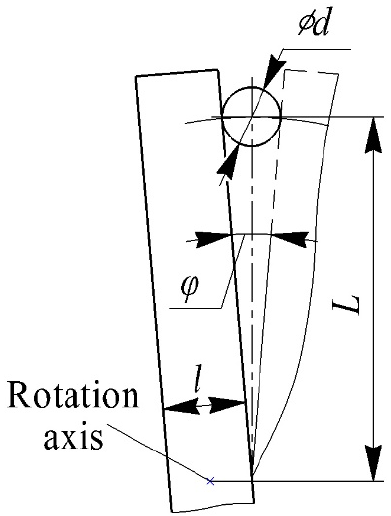
Figure 7. Blade overlap diagram for calculating the time during dynamic calibration of the measur- ing system: l —blade width; L —distance from the blade axis to the center of the hole; d —nozzle hole diameter; φ —nozzle overlap angle.